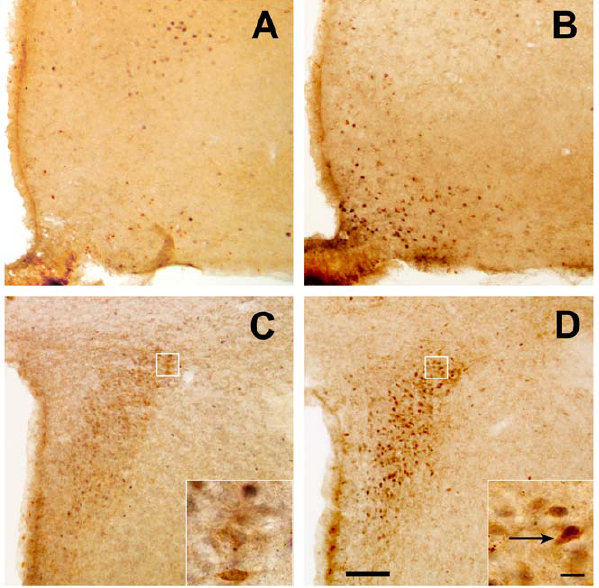
Figure 2. ICV ghrelin administration activates CRF neurons of the PVN. Panels show representative photomicrographs of brains sections subjected to double immunohistochemistry using anti-CRF (brown staining) and anti-c-fos (purple-black staining) antiserum. Upper panels show the ARC and bottom panels show the PVN. Images of panel A and C are from a vehicle-treated mouse and images of panel B and D from a ghrelin-treated mouse. Inserts in PVN images show high magnification of areas marked in low magnification images. Arrows point to dual-labeled cells. Scale bars, 100 m m (low magnification), 10 m m (high magnification). ( Figure 3A ), which went from 1.42 6 0.09 relative CRF mRNA levels in the control to 2.15 6 0.24 relative CRF mRNA levels, at 15 min post treatment (P , 0.05, n= 5 per group). Also, ghrelin induced a significant increase in plasma corticosterone levels at 15, 30 and 60 min post treatment. The maximum response was observed at 60 min post treatment ( Figure 3B ), when plasma corticosterone was 8.7 6 1.5 ng/mL in ghrelin-treated mice and 1.7 6 0.4 ng/mL in saline-treated mice (P , 0.05, n= 5 per group).